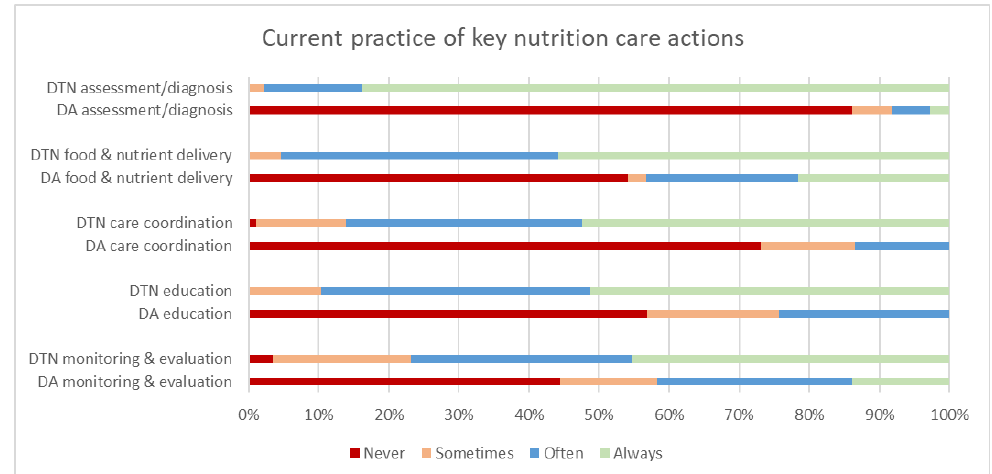
Figure 3. Current practice of key nutrition care actions by dietitians’ (DTN) ( n = 86) and dietitian assistants’ (DA) ( n = 35) *. * An additional two dietitian assistants completed 4 of the 5 question sub-components.